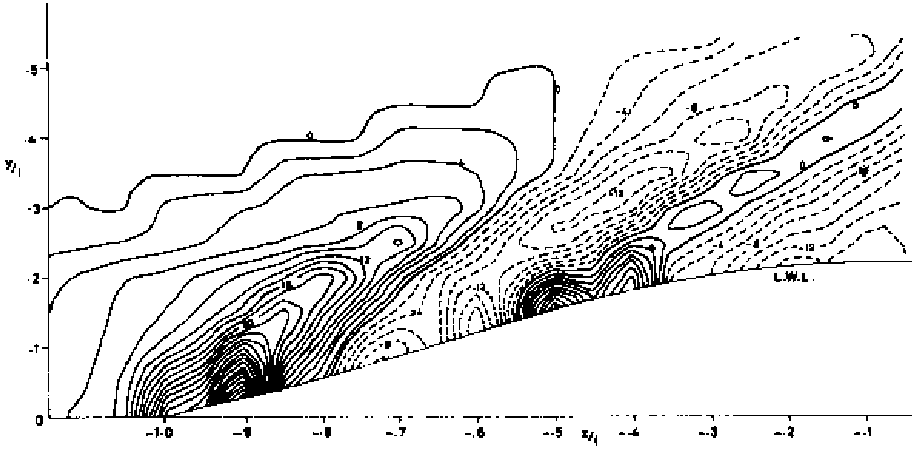
Figure 6. Contours of waves in the near model (wave height in mm) Fn = 0.267.